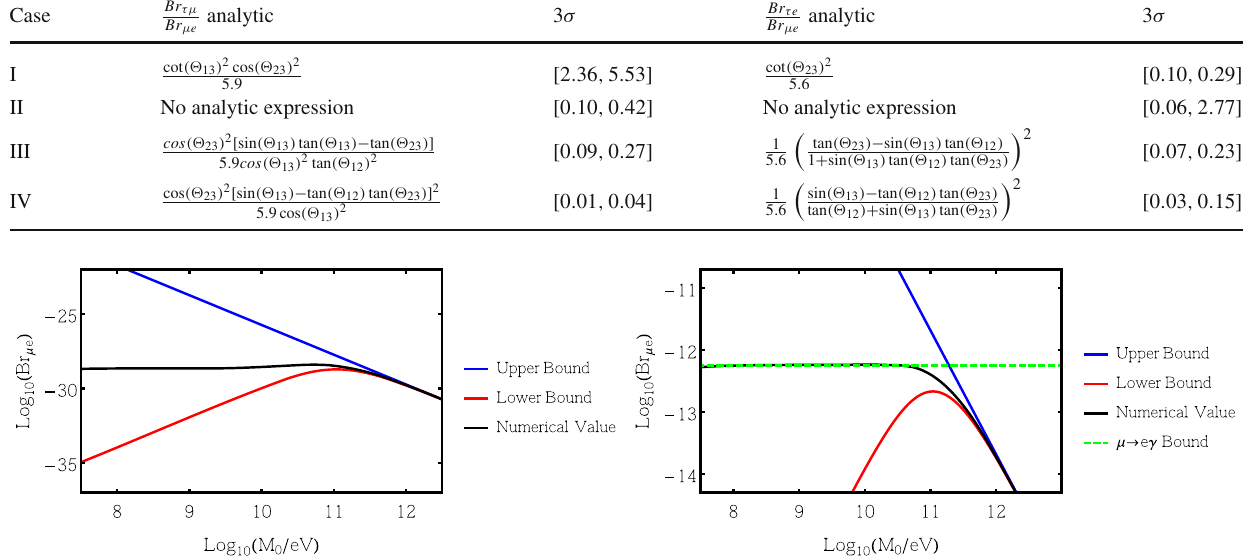
Table 3 Analytic expressions (LO in δ(cid:9) ) for the ratios of the branching ratios of the rare lepton decays in terms of the mixing angles and their 3 σ regions for the different cases. Case I and II correspond to NO and Case III and IV to IO Case